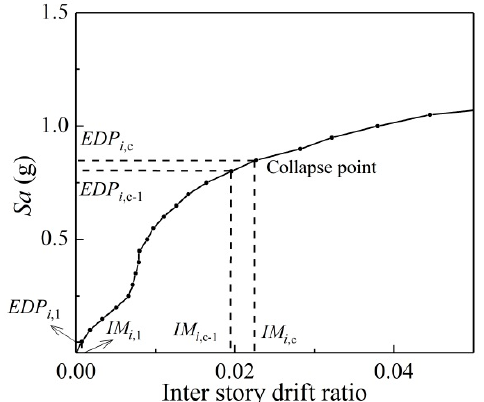
Figure 1. The description of the tangent ratio (TR) based on the incremental dynamic analysis (IDA) curve of i th storey.